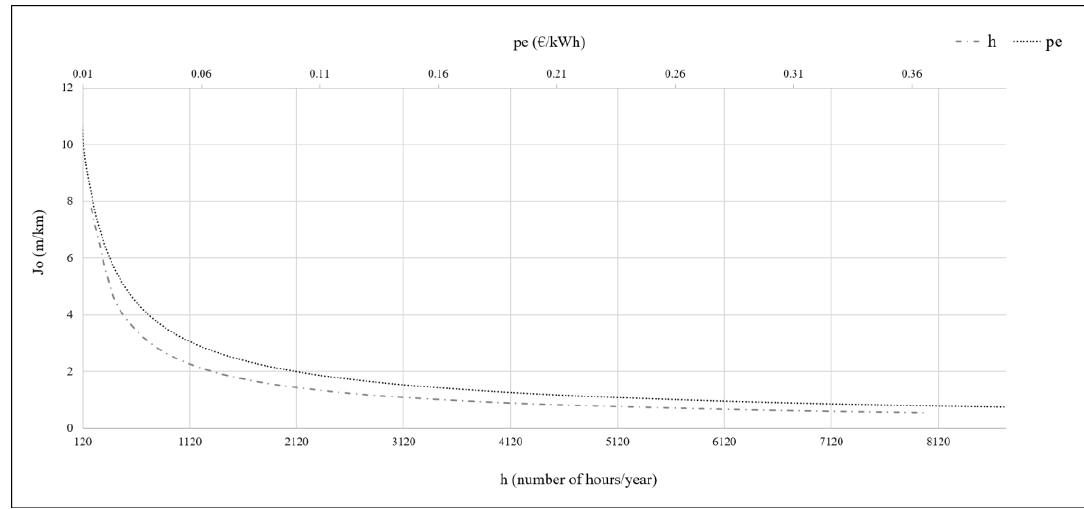
Figure 9. J 0 sensitivity to two significant operating expenditure (OPEX) parameters (case 1, steady network).